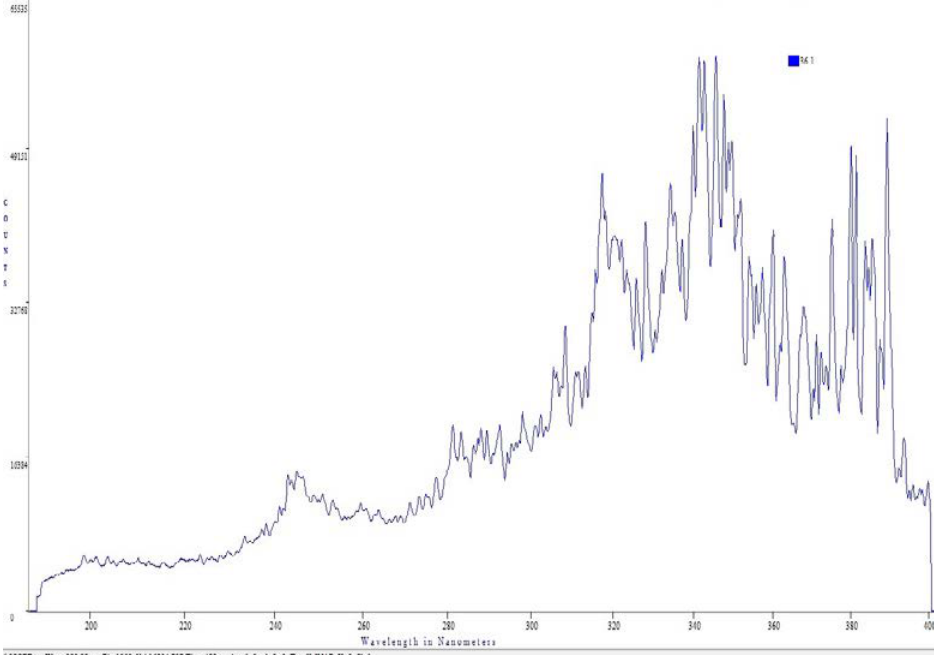
Fig.3: Emission spectra of laser energy 650 mJ with (1Hz) repetition rate.